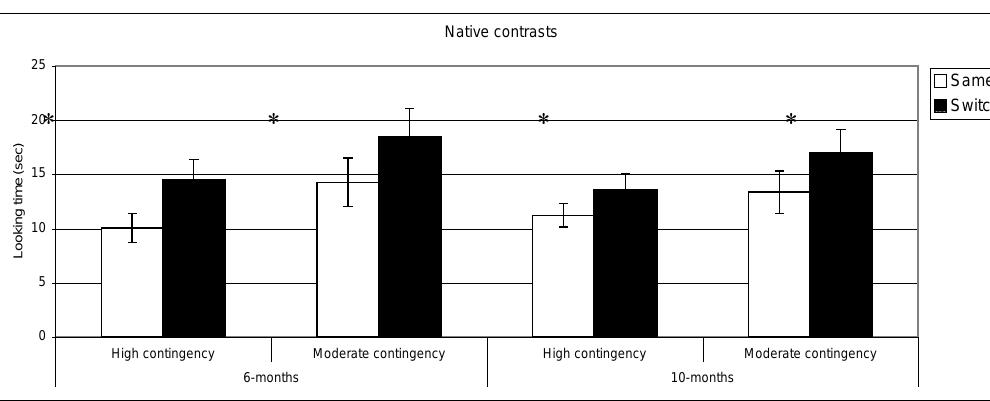
Figure 3. Looking time during same and switch trials for native contrasts at 6- and 10-months for subgroups of infants (* p <